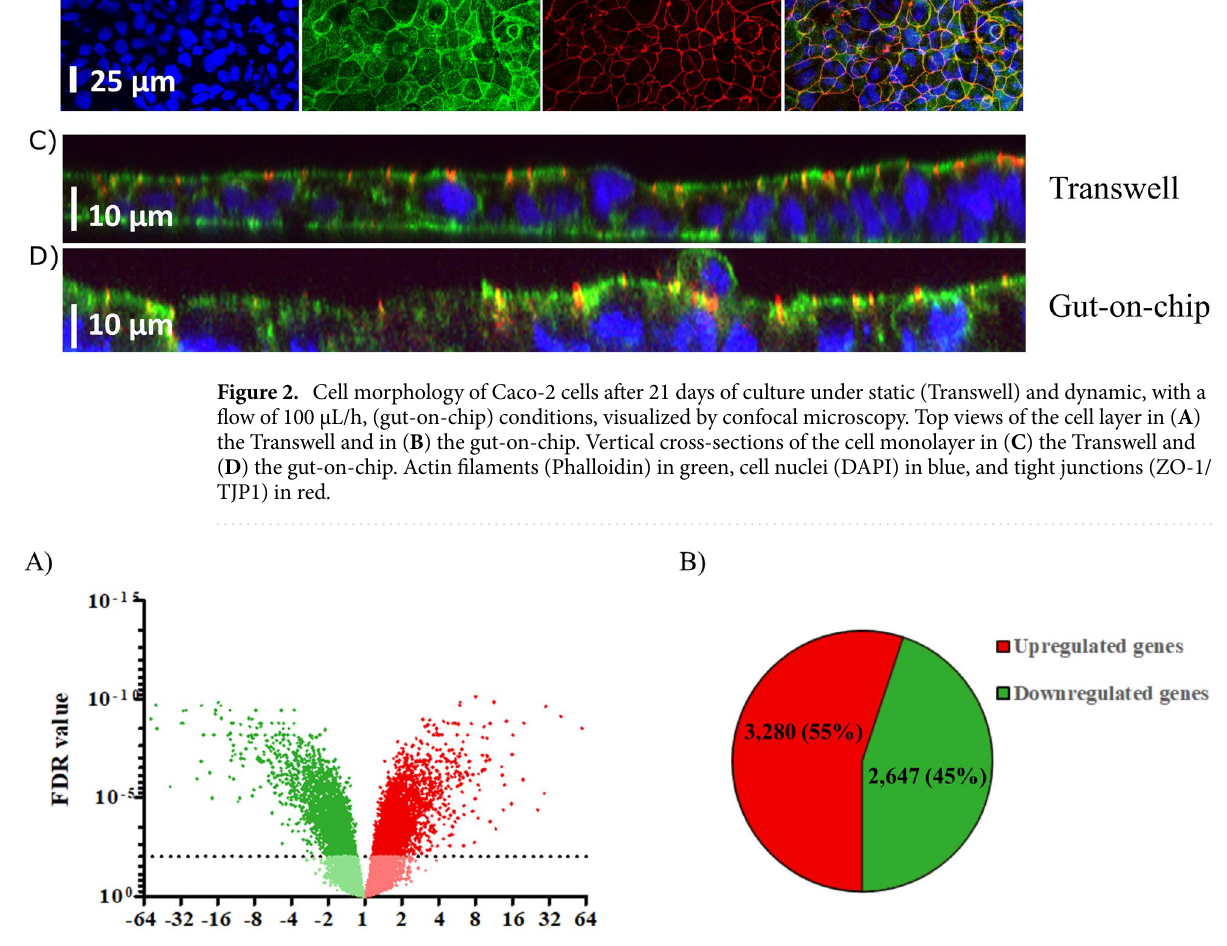
cesses were potentially affected in cells cultured under dynamic conditions compared to cells cultured under